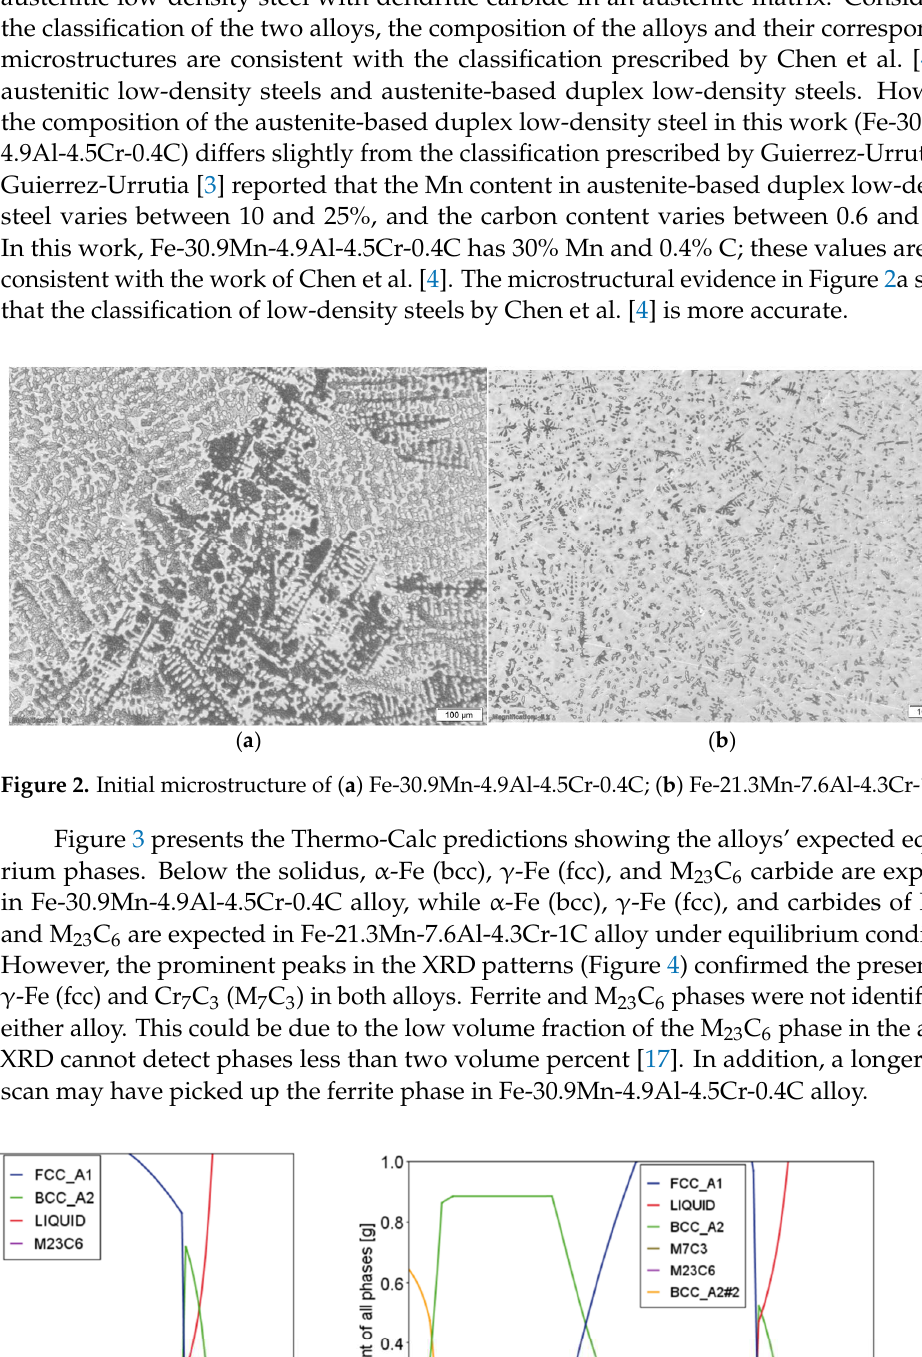
Figure 4. X-ray diffraction pattern of Fe-30.9Mn-4.9Al-4.5Cr-0.4C and Fe-21.3Mn-7.6Al-4.3Cr-1C low-density steels. 3.2. Flow Behavior and Hardness The flow stress curves in Figure 5 were obtained from hot compression tests on the Gleeble using deformation temperatures (800, 900, and 1000 °C) and stain rates (0.1 and 5 s −1 ). The flow stress was sensitive to both the deformation temperature and strain rate. As expected in materials with positive strain rate sensitivity, the flow stress increased with increasing strain rate and decreasing deformation temperature [13,18]. Generally, it is re- ported that when low-density steels are subjected to hot working, the flow stress is higher at low temperatures and high strain rates, while it is lower at high temperatures and low strain rates [2]. The curves show that the flow stress increased drastically at the beginning of deformation until a peak stress, after which the softening effects on flow stress became obvious. The initial increase in flow stress depicts the dominance of work hardening [13– 15]. This metallurgical phenomenon is controlled by the relationship between dislocation mean free path and dislocation length [19]. The work hardening rate is increased by de- creasing the mean free path of dislocations [20]. The decrease in the mean free path de- pends on dislocation density and grain size; therefore, higher strain rates increase dislo- cation density while smaller grain size increases grain boundary area. Therefore, the mean free path of dislocation is decreased by high dislocation density and small grain size, caus- ing dislocation motion impediment [19].